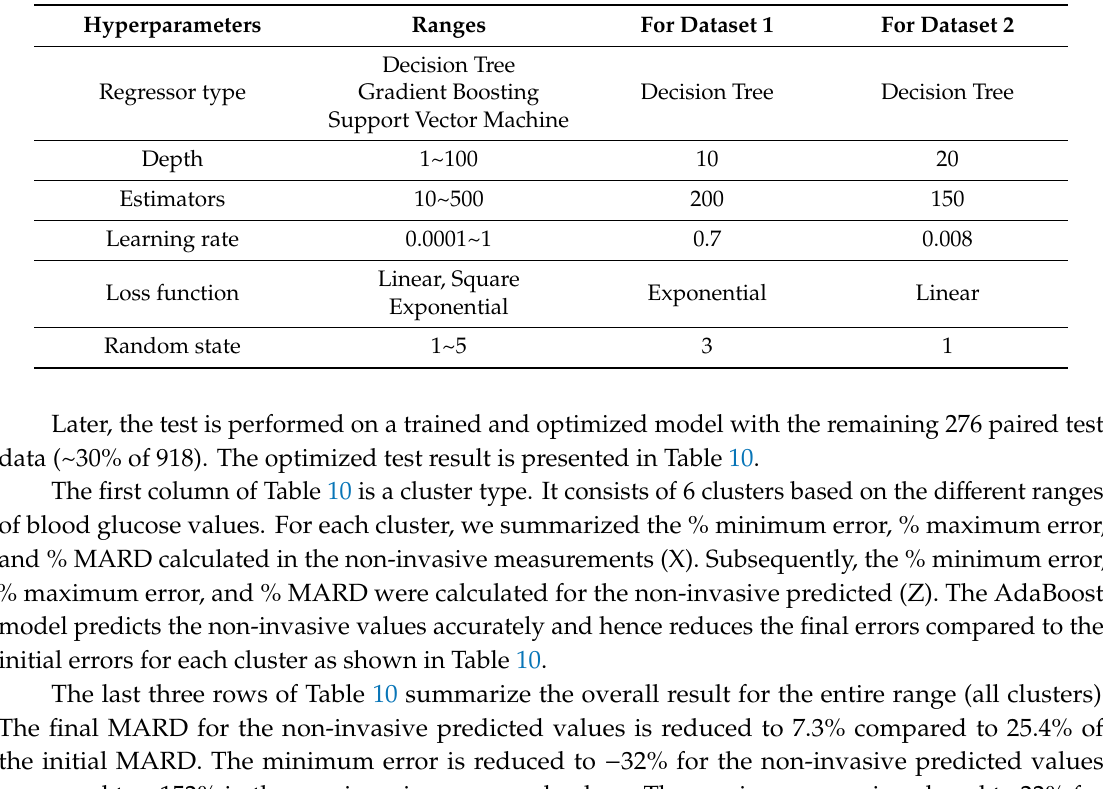
Table 9. Optimized hyperparameters